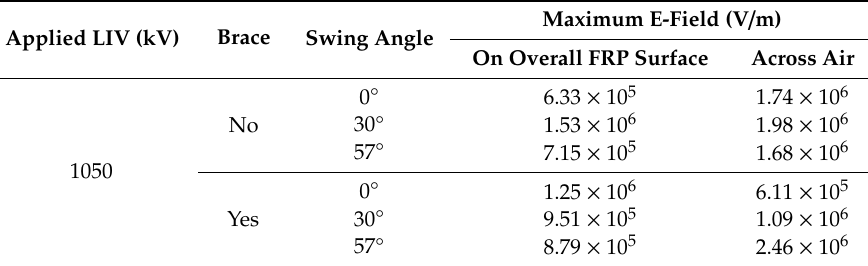
Table 4. Maximum electric field under BIL voltage.